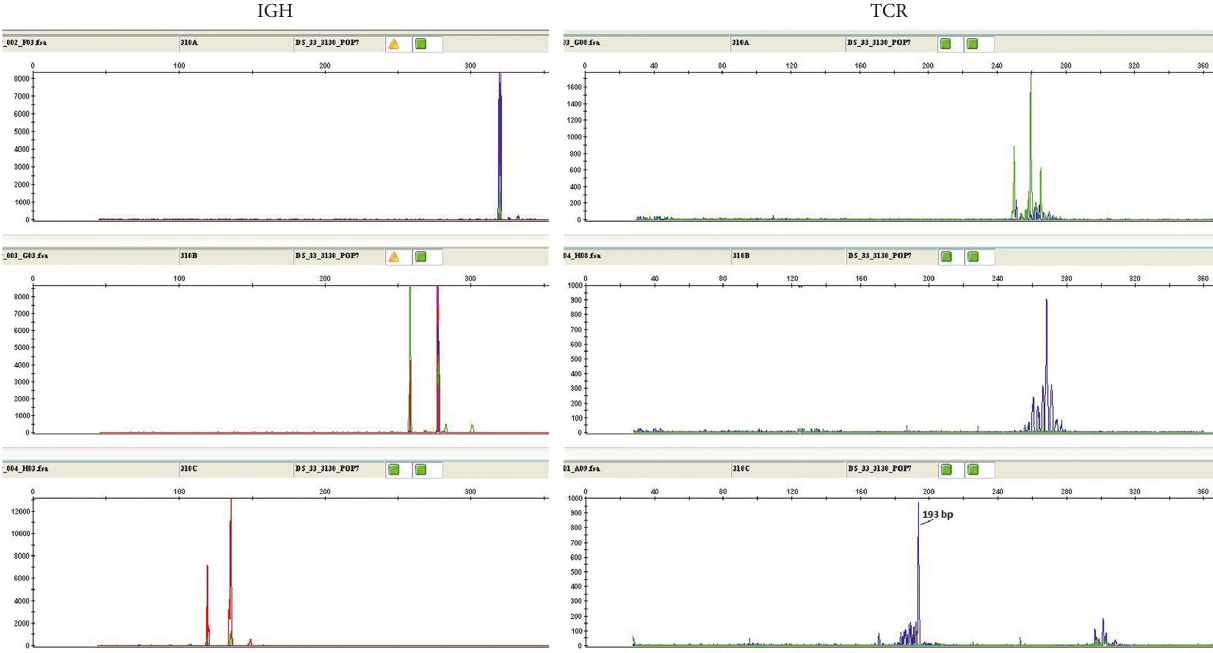
Figure 5: Molecular diagnostics of composite lymphoma. Clonality of the B cells and T cells was assessed for IGH and TCR β gene rearrangements by PCR. Clonal peaks of IGH rearrangement were detected with framework I–III primers. An incomplete rearrangement was revealed of β chain of T-cell receptor: a clonal peak at 193bp (panel